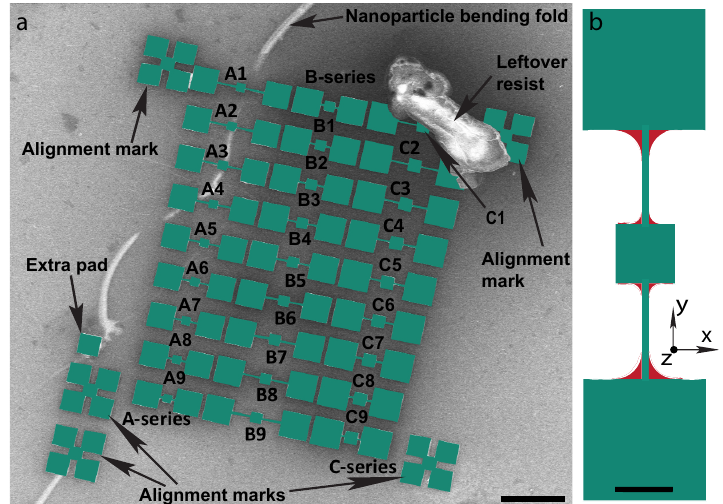
Figure 3. False color SEM image of self-assembly of nanoparticles on SOI fabricated devices. ( a ) Three rows of devices are named as A, B and C series with numbers 1–9. Green color shows the suspended silicon devices with a silicon oxide layer on top of the silicon base (gray color). The alignment marks are the edges of the devices and are also suspended and shown in green color. A single extra pad beside the alignment mark was left behind after etching. The scale bar is 10 µ m. ( b ) Schematic of the anchoring of nanoparticles at the corners of the device. The green color is the device and red color indicates the anchored nanoparticles. The scale bar is 3 µ